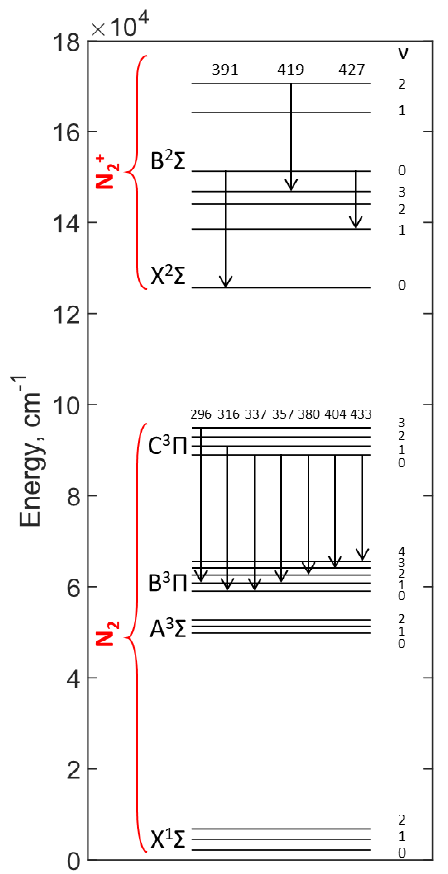
Figure 6. Part of the bands of N 2+ (B 2 Σ –X 2 Σ ) and N 2 second positive system (C 3 Π –B 3 Π ). The emission wavelengths are labeled on the top of each transition arrow. The unit of the wavelength is nm. Vibrational energy levels are listed from the ground state (X 1 Σ ) to the third excited state (C 3 Π ) for N 2 molecules and the ground state (X 2 Σ ) to the second excited state (B 2 Σ ) for NO molecules. The spectroscopic data of N 2 system was taken from Ref. [30].